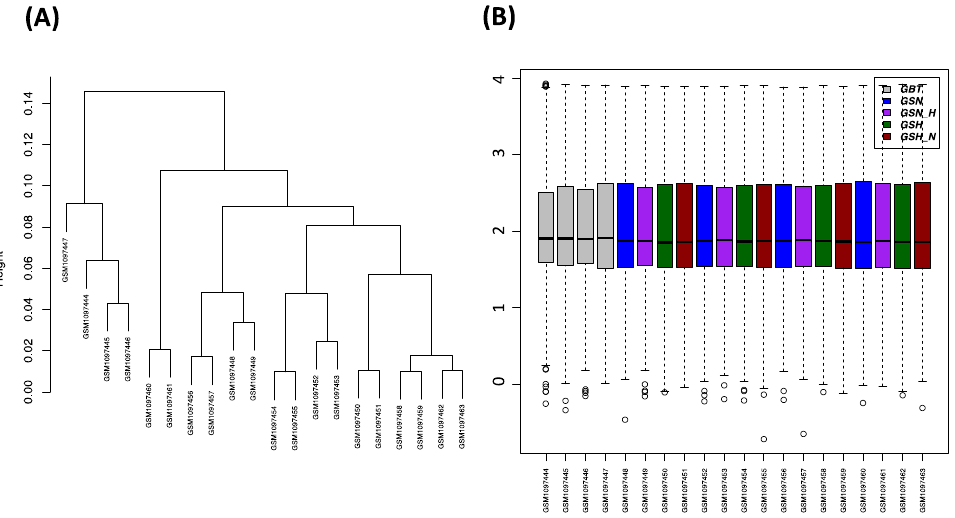
Figure 2. ( A ) A hierarchical clustering plot of gene expression dataset of expression values base-2 logarithmic value. ( B ) The boxplot of the GSE45117 gene expression dataset within each sample.